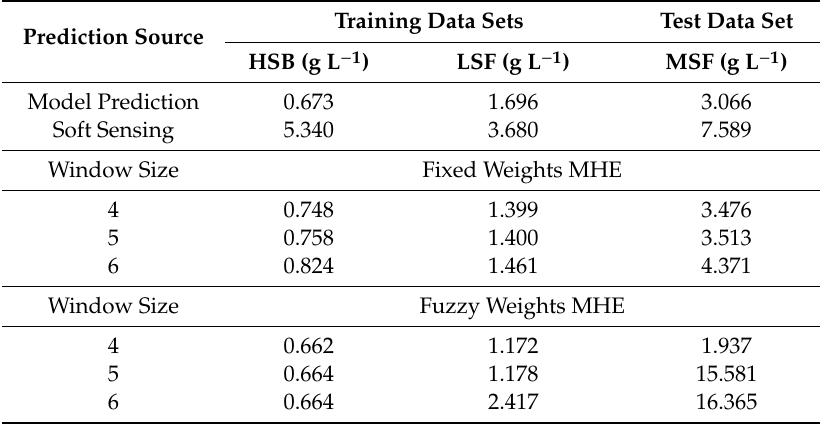
Figure 6. Carbohydrates concentration prediction for optimum Artificial Neural Network (ANN) for Mixed Solids Fed-batch (MSF) predictions; top graph is input variables to the network, middle and bottom graphs are glucose and xylose predictions; error bars in data points are standard errors between experiment duplicates for compound concentration; vertical dotted lines are the biomass feeding times. Table 4. Root Mean Squared Error (RMSE) of product predictions for all Moving Horizon Estimator (MHE) tuning conditions as well as pure model and soft sensing.